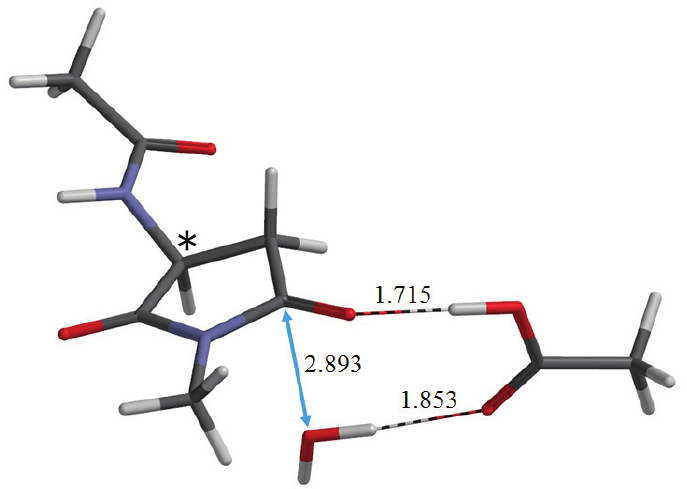
Figure 9. The geometry of the product complex P•AA•W ( φ = − 173°, ψ = − 140°, χ 1 = 137°) formed by the succinimide product P, the regenerated acetic acid molecule AA and the released water molecule W. Selected interatomic distances are shown in Å. The asterisk (*) indicates the α